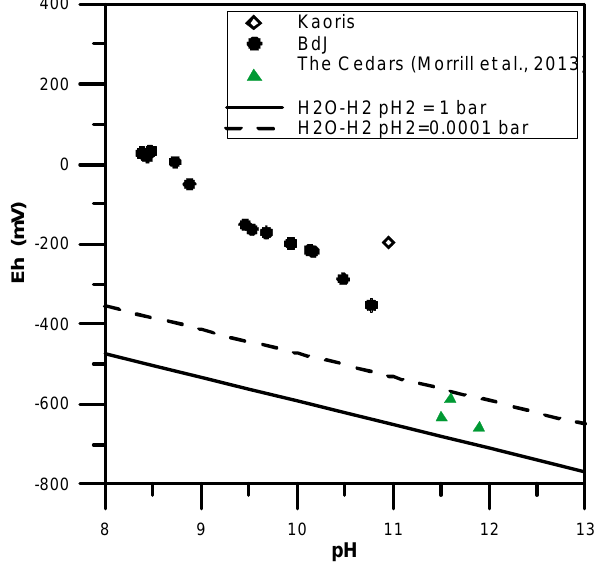
Figure 4. Redox potential measured in situ at the springs of the Bain des Japonais, of the Rivière des Kaoris springs (this work) and of The Cedars site (California; (Morrill et al., 2013). The plain line represent the redox potential calculated at a temperature of 25 ◦ C for the equilibrium between water and hydrogen at a H 2 (g) partial pressure of 1bar and the dashed line at a H 2 (g) partial pressure of